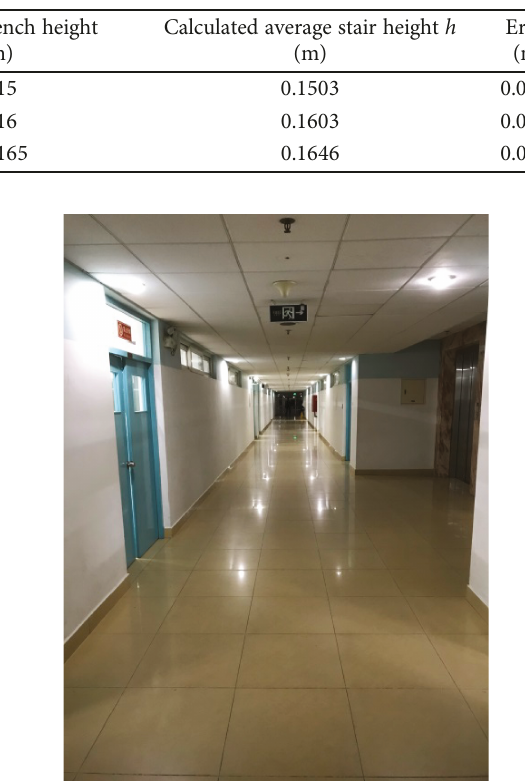
Table 1: Performance of the stair height calculation method.